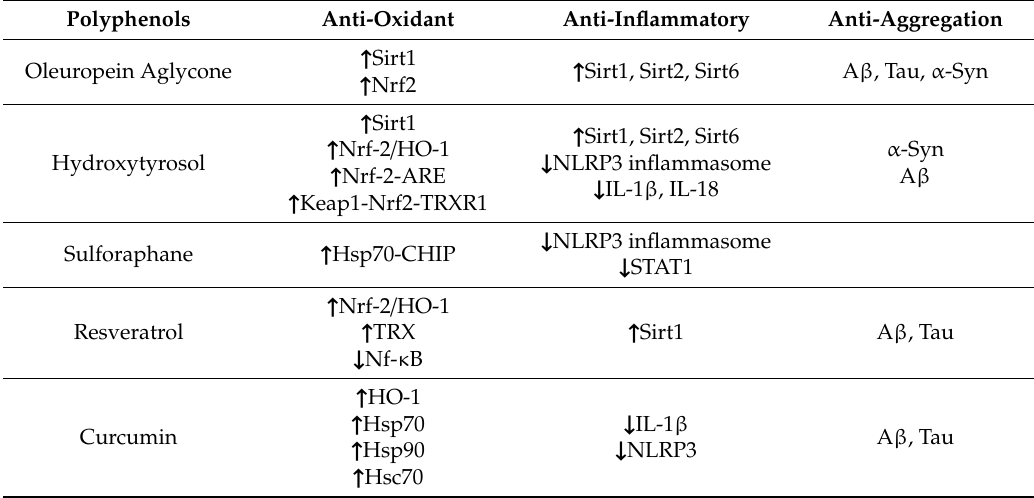
Table 2. Polyphenols activity in cellular protective pathways. Activated pathways: ↑ ; Inactivated pathways: ↓ . Polyphenols Anti-Oxidant